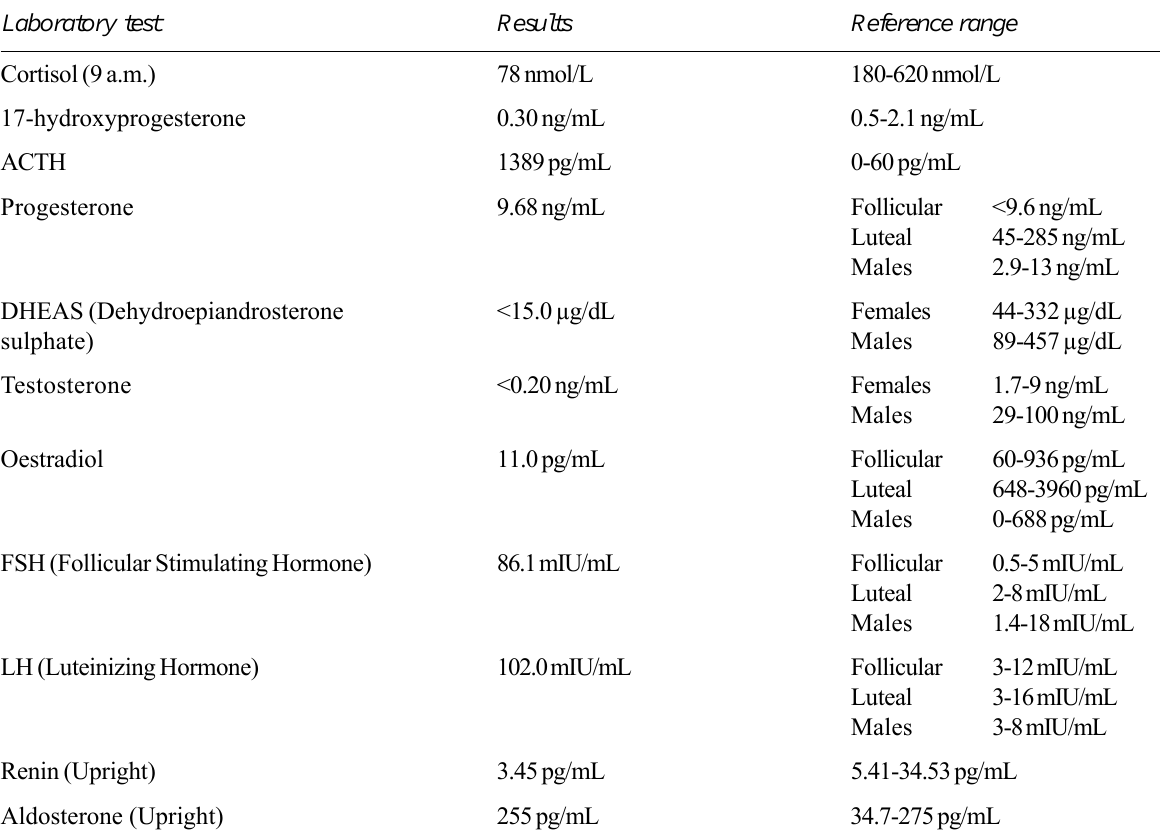
Table 1. Results of biochemical investigations